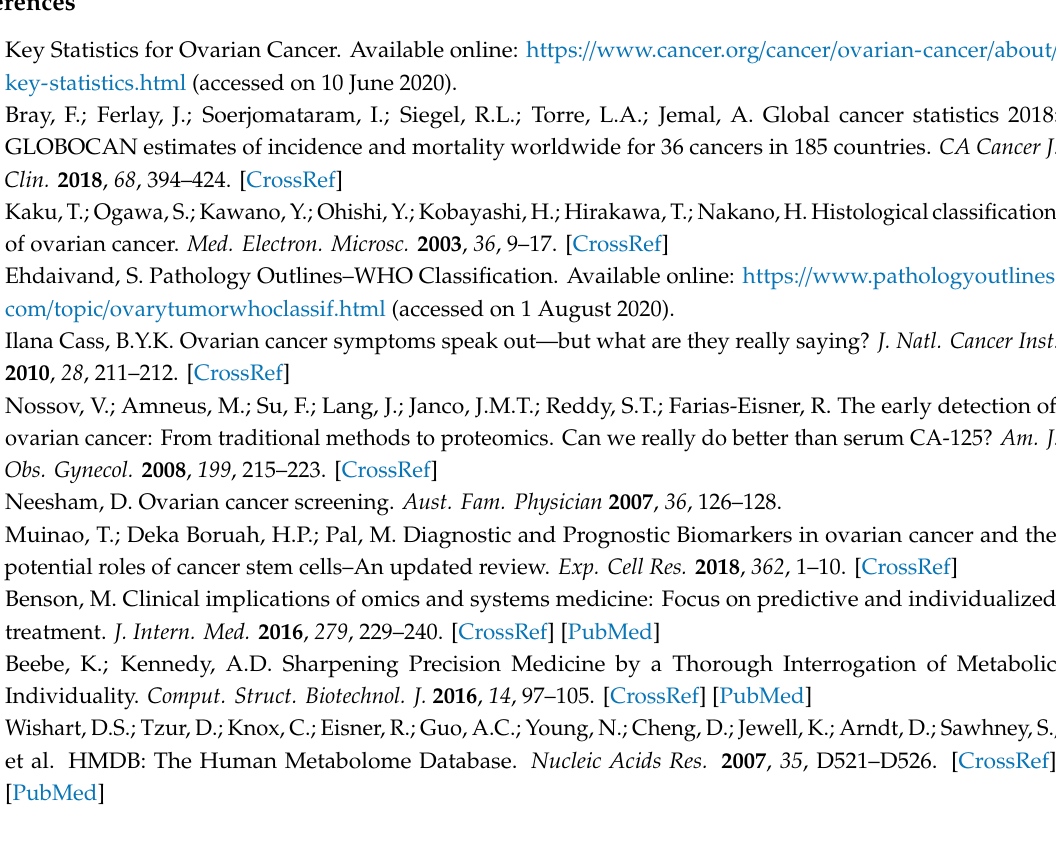
Figure S1: Identified altered lipids metabolites, Figure S2: identified altered AA metabolites, Figure S3: identified altered central carbon metabolites, Figure S4: other metabolites identified as significantly altered, Table S1 QUADOMICS evaluation of selected